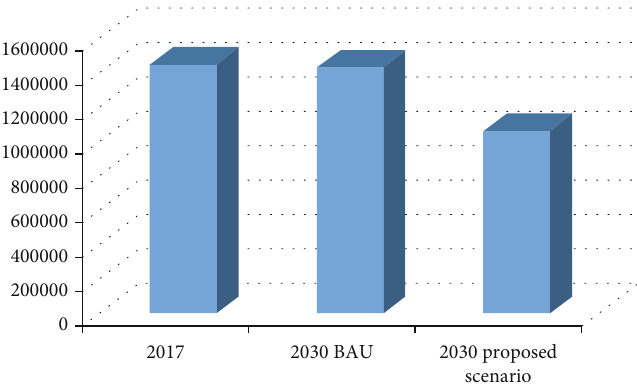
Figure 7: Total greenhouse gas emissions of 2017, 2030 BAU, and 2030 proposed